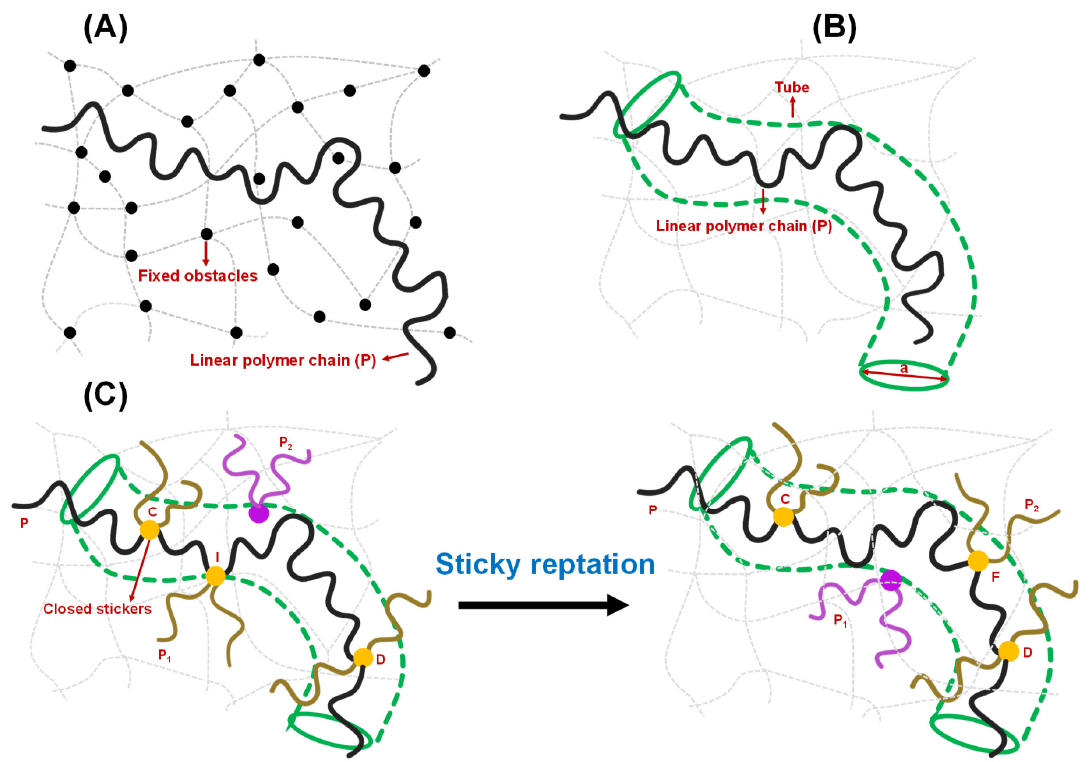
Figure 4. Different models of polymer entanglement. ( A ) Conceptualization of reptation of a polymer chain (P) in the presence of fixed obstacles, as theorized by de Gennes. The chain can freely move between the fixed obstacles but is not allowed to cross any of them. The fixed obstacles are shown by black circles, and the linear polymer chain is shown by a black strand. The grey dashed lines and curves describe the polymer network. ( B ) Conceptualization of reptation of an infinitely long polymer chain based on the tube model proposed by Edwards and Doi. The polymer chain, shown by black strand, is confined in the tube (olive) of a certain diameter ‘a’ and allowed to move along the contour of the tube. The grey dashed lines and curves describe the polymer network. ( C ) Sticky reptation model of polymer entanglement as proposed by Leibler, Rubinstein, and Colby in the context of associative polymers possessing several ‘associating’ groups (stickers). Initial stage (on left): The linear chain P (black strand) has a crosslink I with chain P 1 (dark gold strand). P 2 (purple) represents the next available chain for crosslink formation. Final stage (on right): a new crosslink F is formed with another chain P 2 (dark gold). In general, the chain that belongs to the crosslink is shown by dark gold strands with yellow circle representing the ‘closed stickers’, otherwise it is shown by purple. During this period, the center of mass of section CD of chain P is moved in a random manner. Details are explained in the main